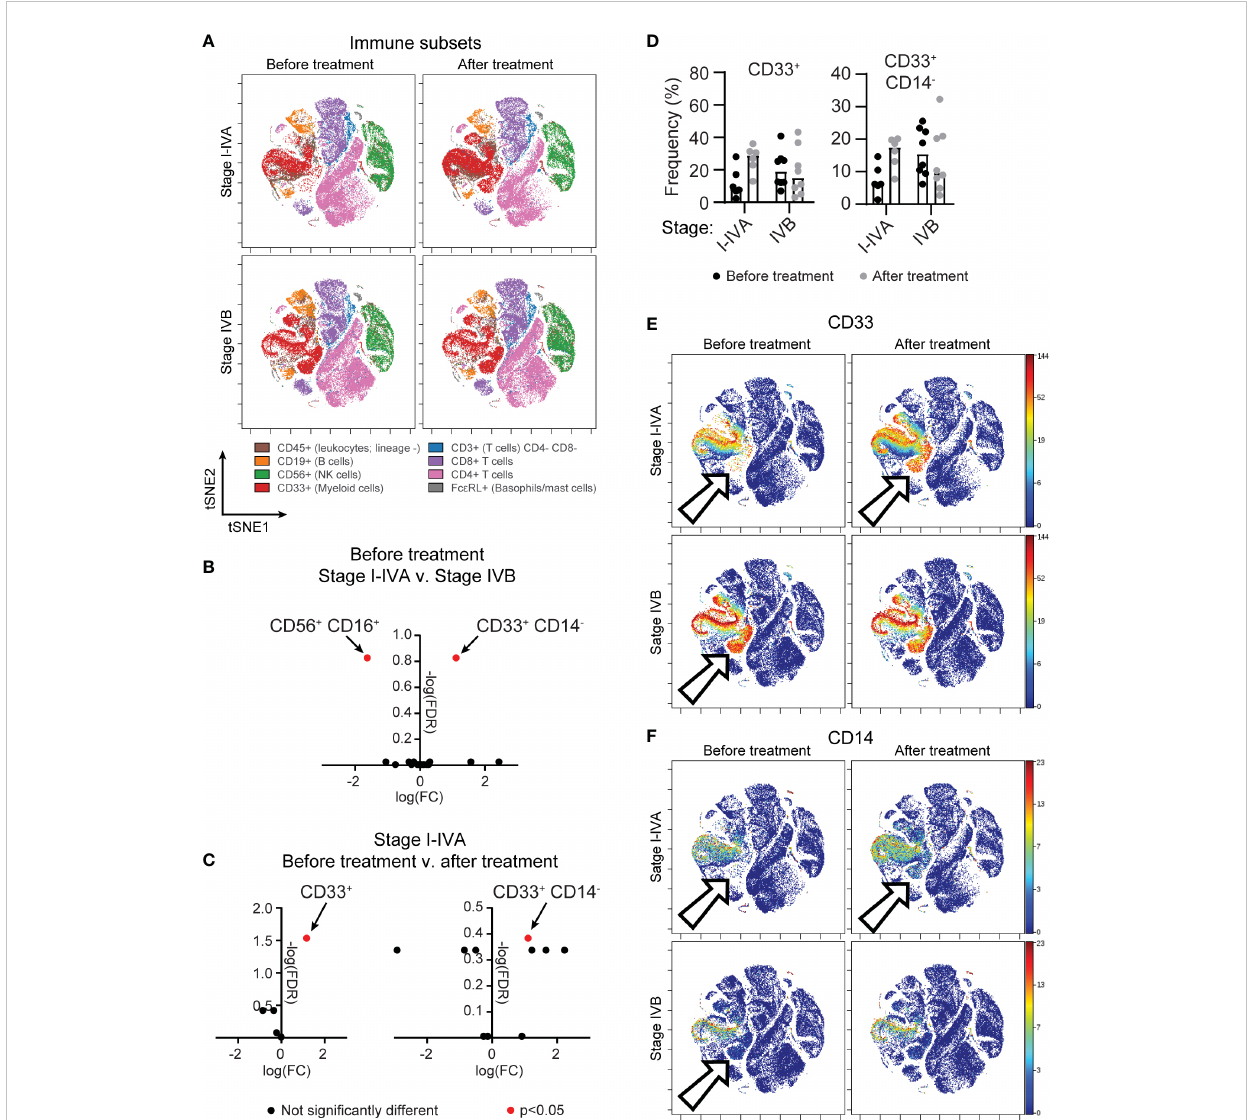
FIGURE 1 A population of circulating CD33+ CD14- myeloid cells is found in advanced NSCLC patients and after treatment onset. PBMC from donors with unresectable lung cancer were obtained from the thoracic/lung nodule biobank. Patients were grouped according to a diagnosis (see Table 1) of stage I-IVA (n=6) or stage IVB (n=8) NSCLC. Matched samples were obtained for all patients before they began therapy and after initial treatment began. (A) tSNE plots show concatenated NSCLC patient samples before or after treatment onset, analyzed by CyTOF, for all CD45+ live